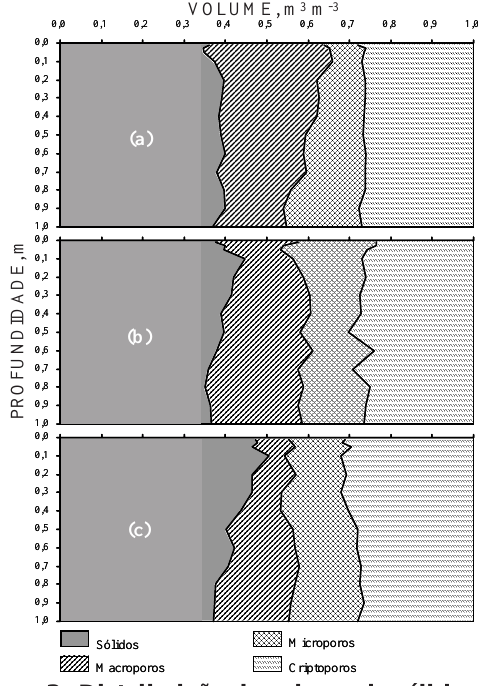
Figura 3. Distribuição do volume de sólidos e das classes de poros no perfil do solo. (a) mata; (b) sequeiro e (c)